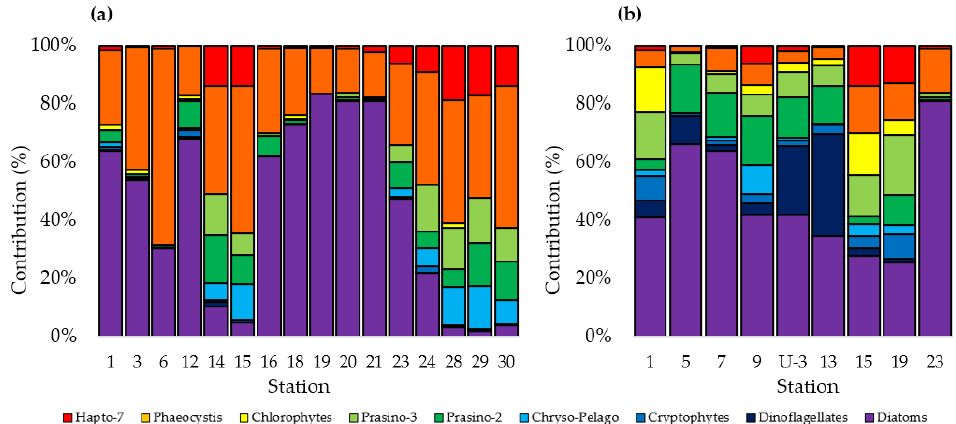
OS040, respectively (Figure 8). The contribution of small phytoplankton to the total pri- mary productivity ranged from 8.1 to 71.7% (mean ± SD = 38.0 ± 19.9%) for the ARA07B and from 6.0 to 40.3% (mean ± SD = 25.0 ± 12.8%) for the OS040 (Figure 9). Figure 6. Phytoplankton community compositions of ( a ) ARA07B and ( b ) OS040.